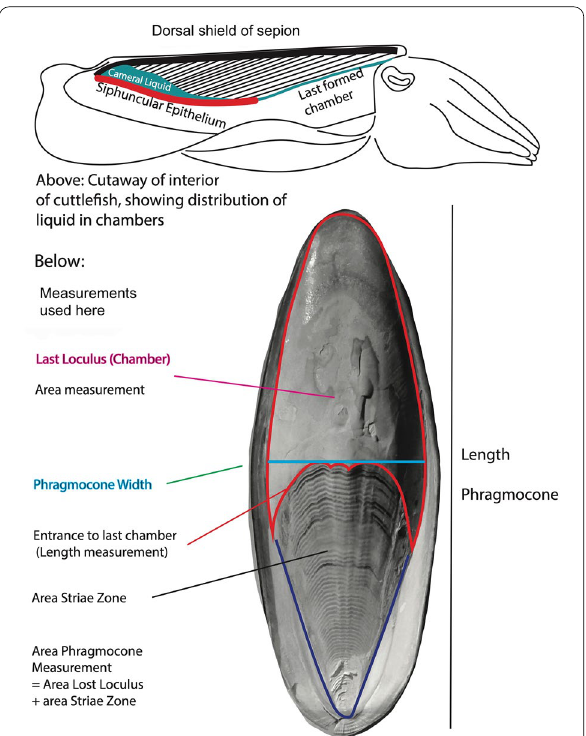
Fig. 1 Above: Sepia orbignyana , brought up by trawl from 400 m for photograph. Mantle length 70 mm. Note use of’ tentacles for keeping station above bottom. This species observed to slowly use tentacles for crawling along bottom. Prototypic deep-water squid. Photo by P.